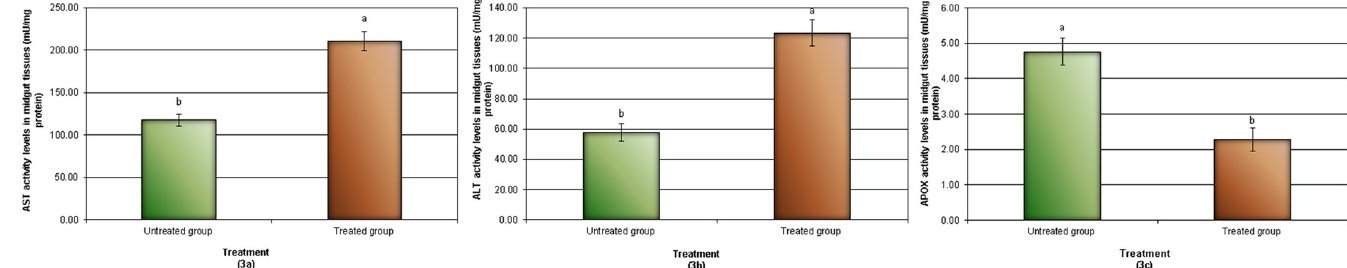
Fig 3. Activities of antioxidant enzymes a: AST, b: ALT, c: APOX in the studied groups. Data are expressed as mean ± SE.